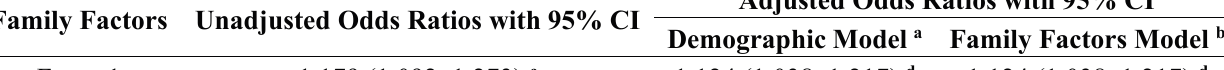
Table 4. Suicidal ideation and correlated family factors using univariate and multiple logistic regression